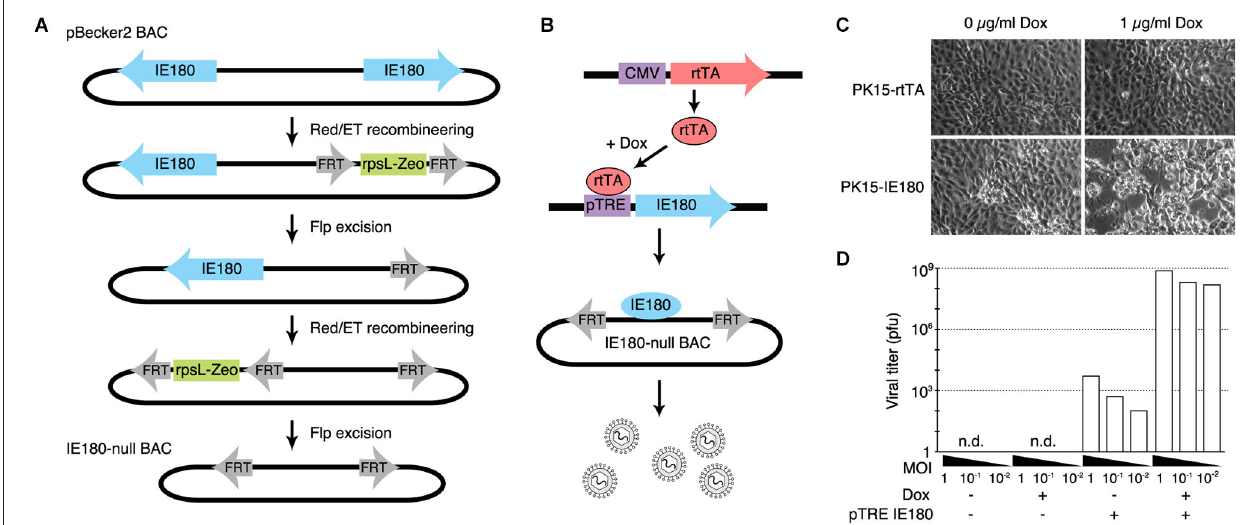
thus viral production. (C) PK15-rtTA cells and PK15-IE180 cells were infected with IE180-null PRV and imaged 48 h later. Cytopathic effects associated with PRV replication were observed only in PK15-IE180 cells and were enhanced by the addition of doxycycline. (D) Titers of viral supernatants produced by PK15 and PK15-IE180 cells infected with IE180-null PRV (harvested 3 days after infection) at MOI of 1, 0.1 or 0.01 quantified on PK15-IE180 cells. No infectious material can be detected in supernatants of PK15 cultures lacking